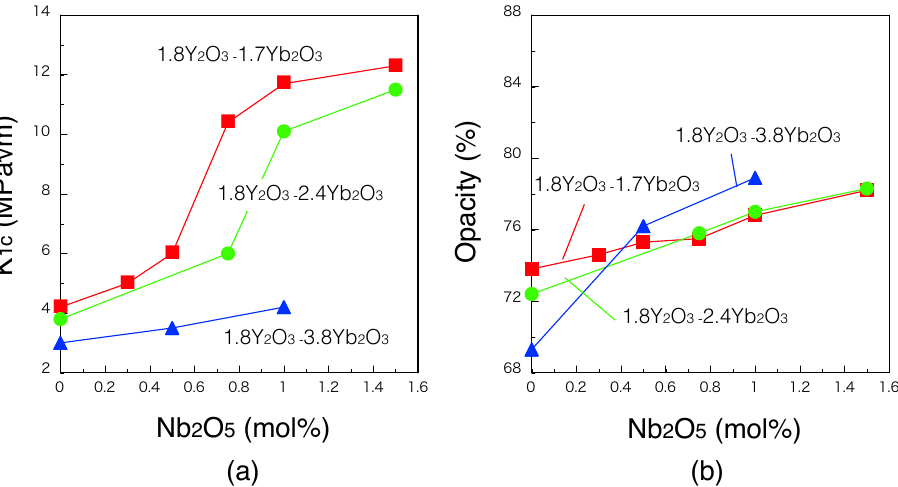
Figure 4. The effect of Nb 2 O 5 content on ( a ) fracture toughness and ( b ) opacity of ZrO 2 -Y 2 O 3 -Yb 2 O 3 - Nb 2 O 5 (No. 6–8 and 31–40).